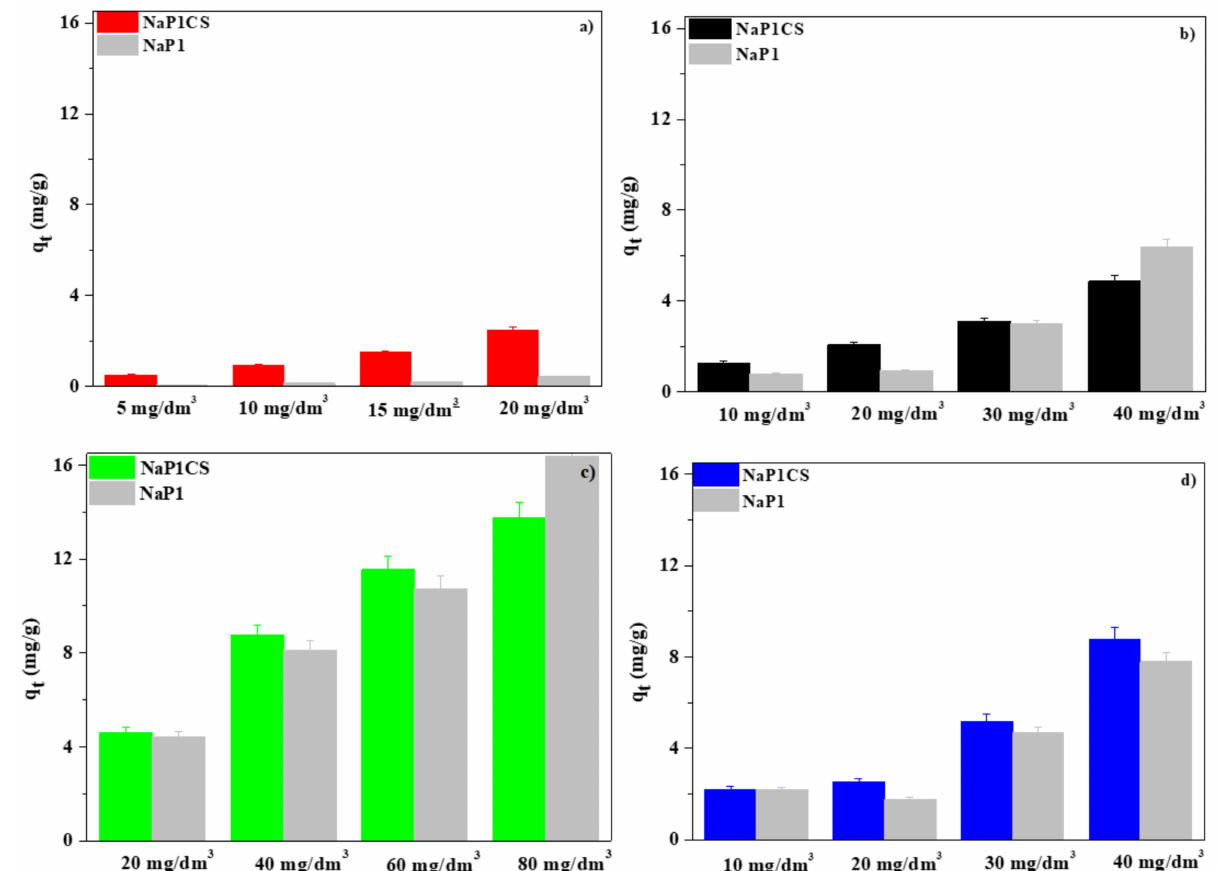
Figure 8. Comparison of the values of sorption capacities obtained for ( a ) Cu(II)–IDHA, ( b ) Fe(III)–IDHA, ( c ) Mn(II)–IDHA,